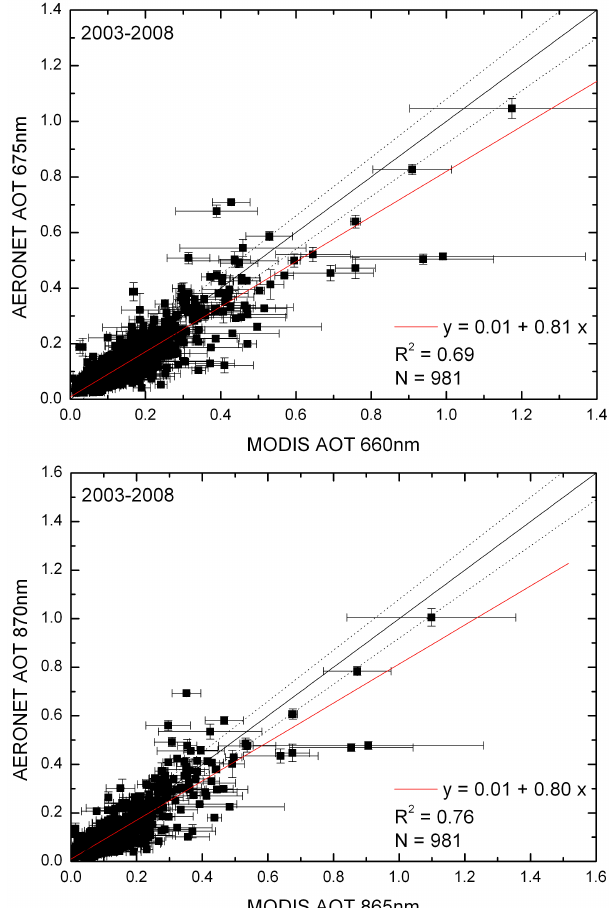
Fig. 3. Scatter plots of means of AOT (660nm (a) and 865nm (b)) of MODIS 50 × 50km subsets against AOT (675nm (a) and 870nm (b) ) of AERONET 1h subsets for the period 2003–2008. The error bars represent the respective standard deviations. The red line is the linear regression fit, with the equation, determination coefficient and number of points used shown at the lower right cor- ner. The dotted lines correspond to the expected uncertainty of the MODIS retrieval